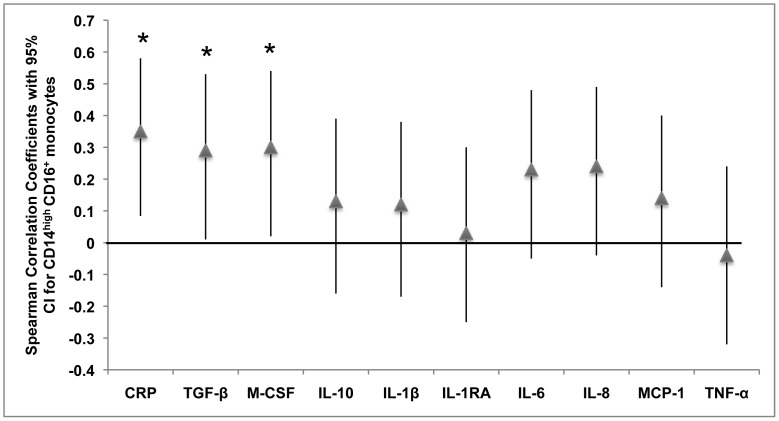
Spearman correlation coefficients with 95% confidence intervals for each factor as a predictor of the percentage of CD14highCD16+ monocytes (n = 50).*, P<0.05.